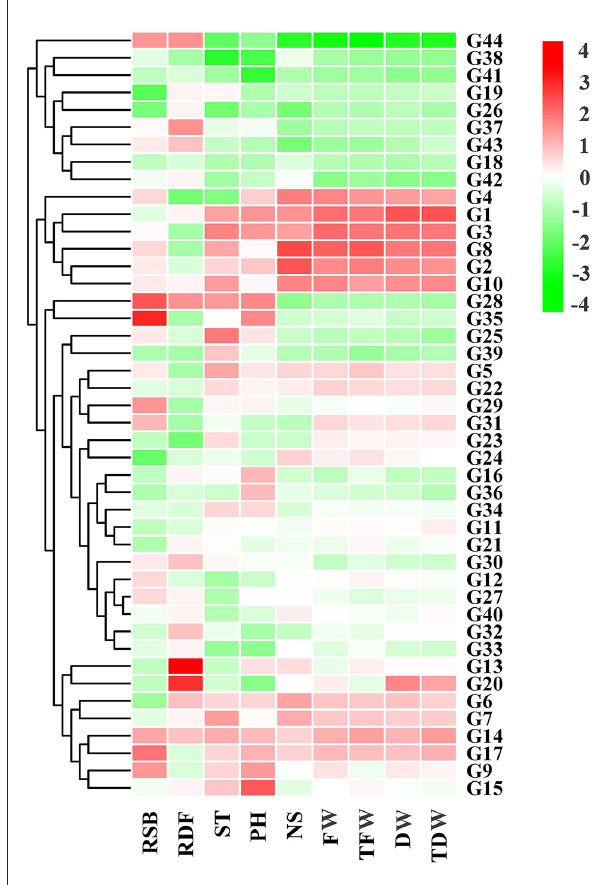
FIGURE3 Heatmap showing 9 agronomic traits of 44 alfalfa varieties cultivated between 2019 and 2020. ST, stem thickness; PH, plant height; NS, number of branches; RSL, stem biomass/leaf biomass ratio; FW, fresh weight; DW, dry weight; RDF, dry weight/fresh weight ratio; TFW, total fresh weight; TDW, total dry weight.